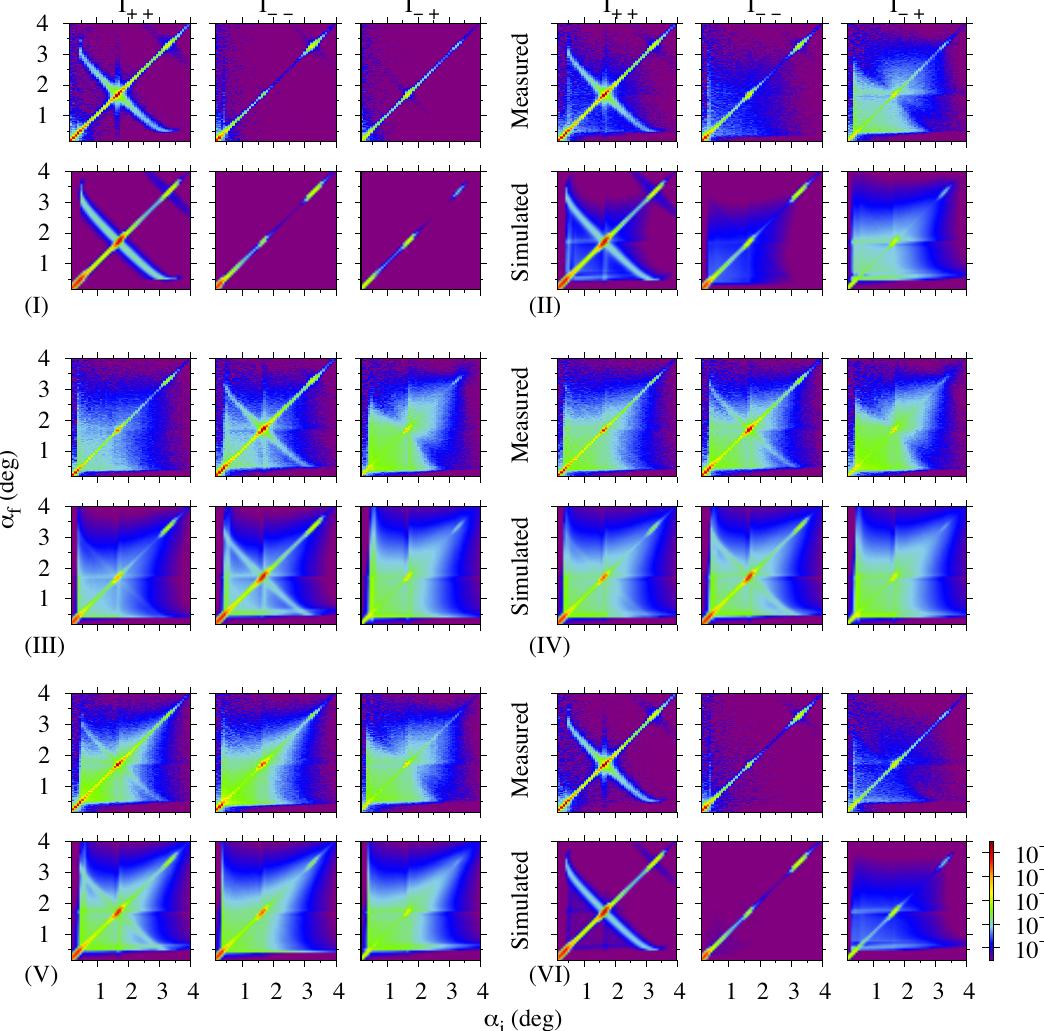
Figure 4. Polarized OSS images of the Fe/Si multilayer. (I)–(VI) correspond to the measured conditions shown in Figure